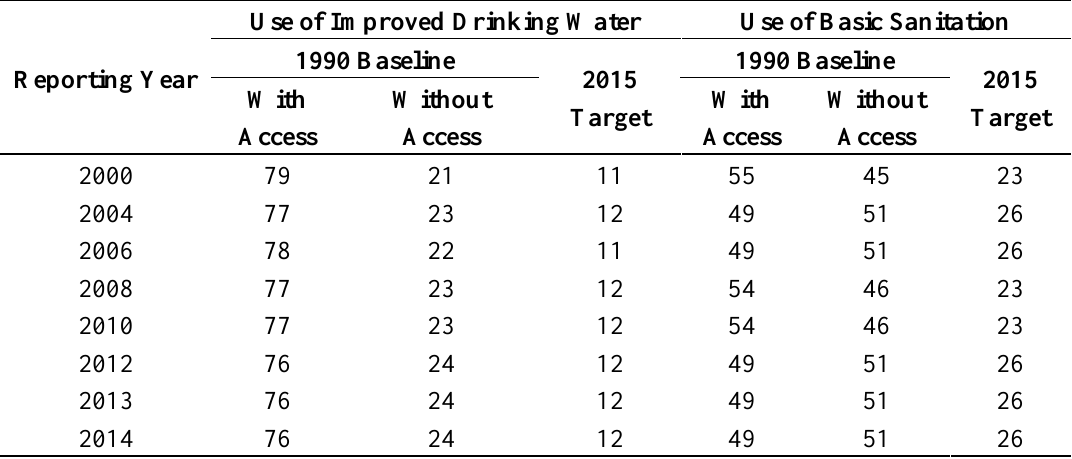
Table 4. 1990 Baseline Global Coverage Percentages as Estimated in Different Years. Use of Improved Drinking Water Use of Basic Sanitation Reporting Year With